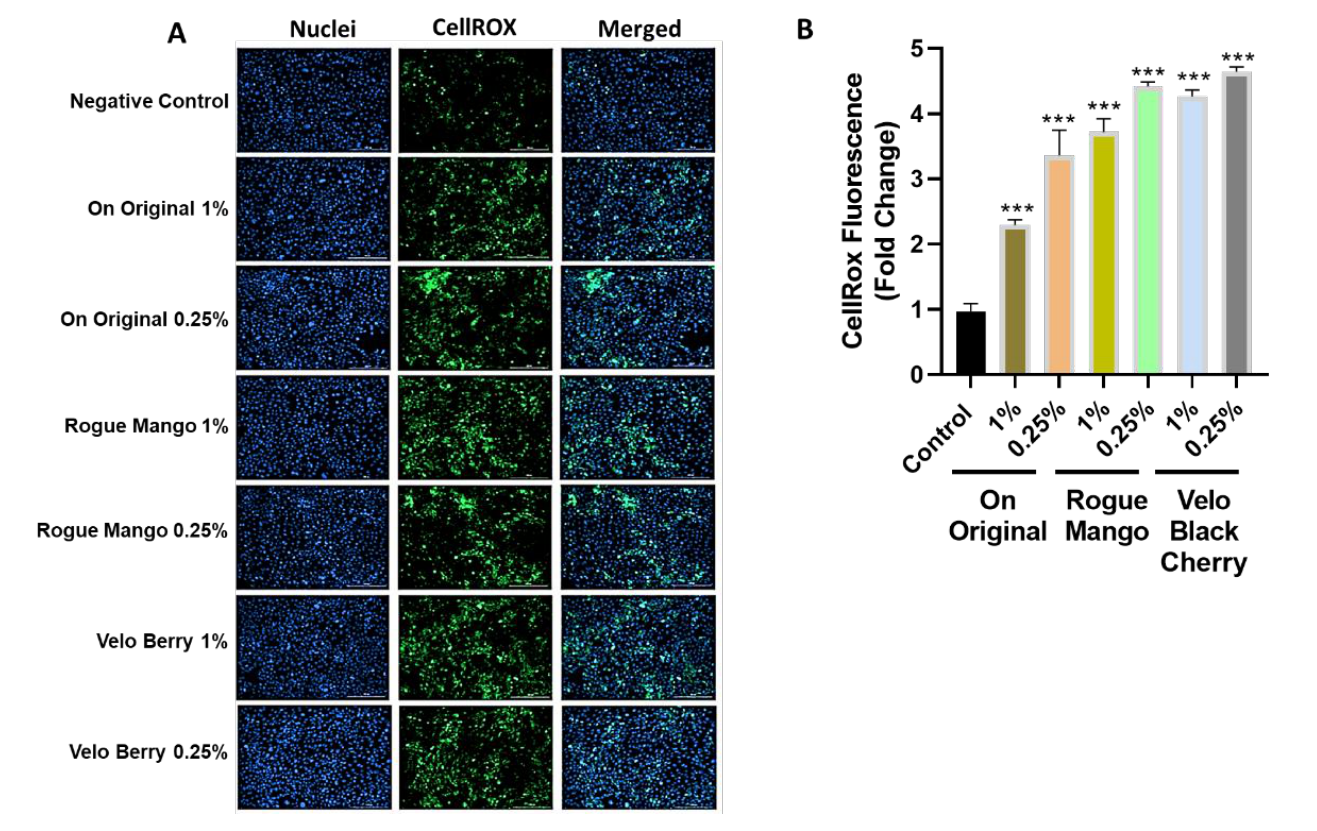
Figure 6. Production of ROS was measured in 16 HBE cells after treatment with different flavors of nicotine pouches. 16HBE cells were serum-deprived and were treated with ON! Original, Rogue mango, or Velo black cherry flavored nicotine pouch extracts and incubated for 4 h. Following the incubation oxidative stress measurements were carried out using CellROX Green Reagent. ( A ) Fluo- rescence images displaying the production of ROS and nuclear morphology (blue) in 16HBE cells treated with different flavors of nicotine pouch extracts at doses of 0.25% and 1%. ( B ) Quantitative analysis of fluorescence in 16 HBE cells. Data are represented as mean ± SEM. *** p < 0.001. Images were captured by Cytation 5 imaging reader (BioTek) reader and CellROX fluorescent signals were quantified using Image J software ( n = 3). Scale bar = 200 µ